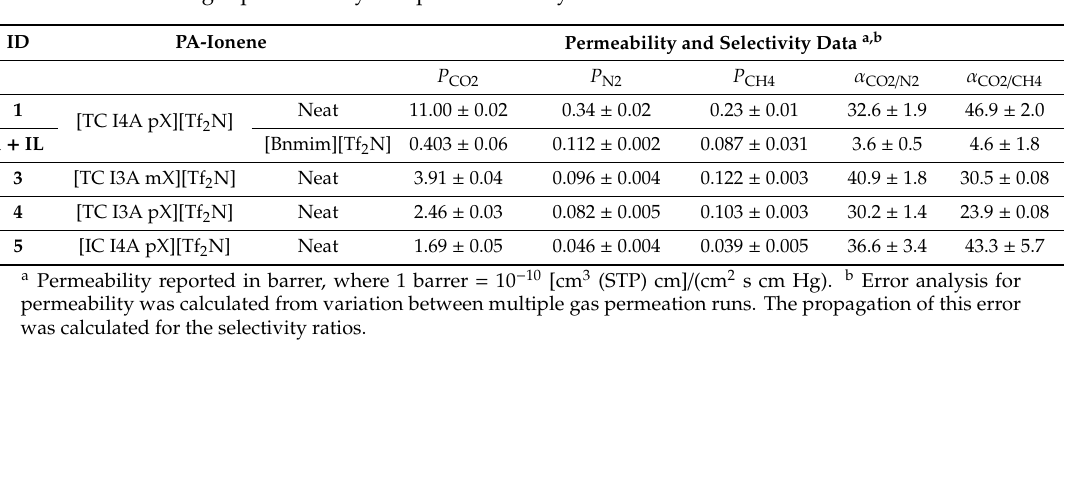
Table 3. Pure gas permeability and permselectivity data for PA-ionenes at 20 ◦ C and ~3